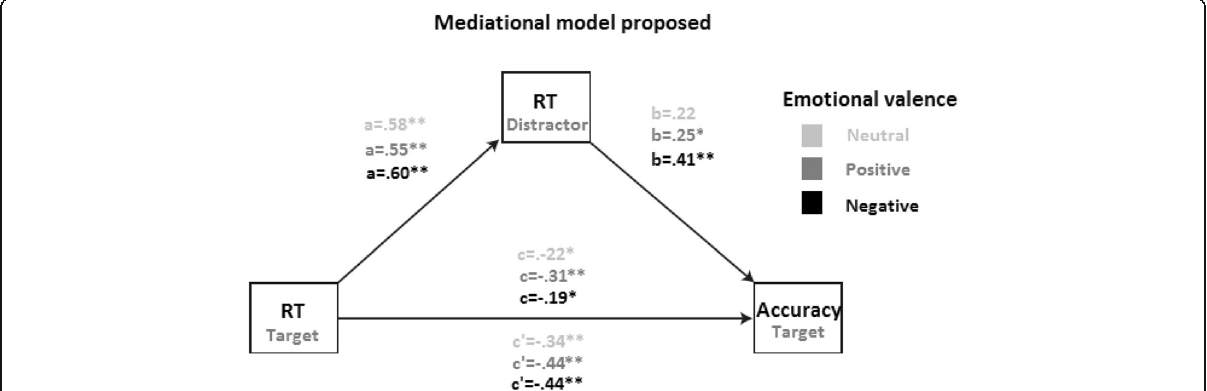
Fig. 2 Mediational model testing how changes in distracting stimuli mediate RT predicting accuracy across emotional conditions